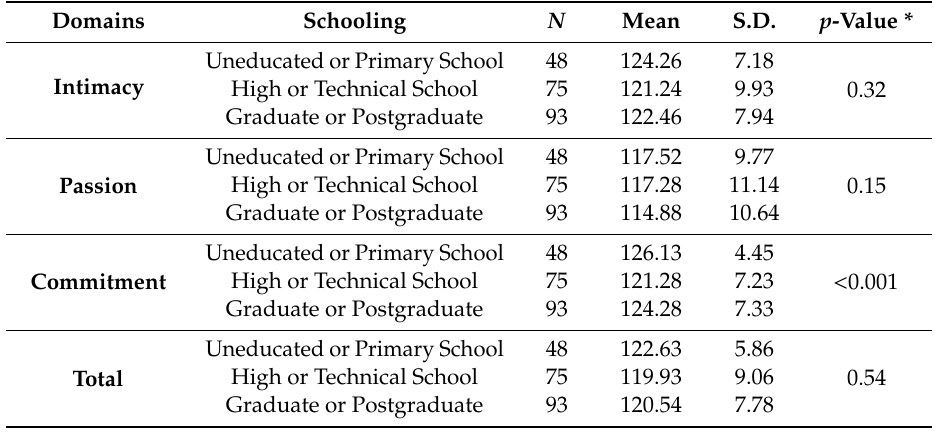
Table 7. The total mean scores of each domain and the total sum test according to the level of